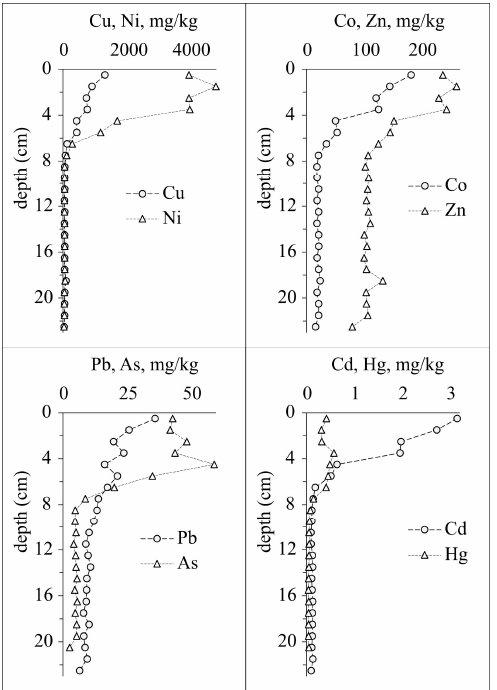
Figure 6. The vertical distribution of heavy metals in sediments of Lake Kuetsjarvi (Murmansk Re- gion) [28,29].